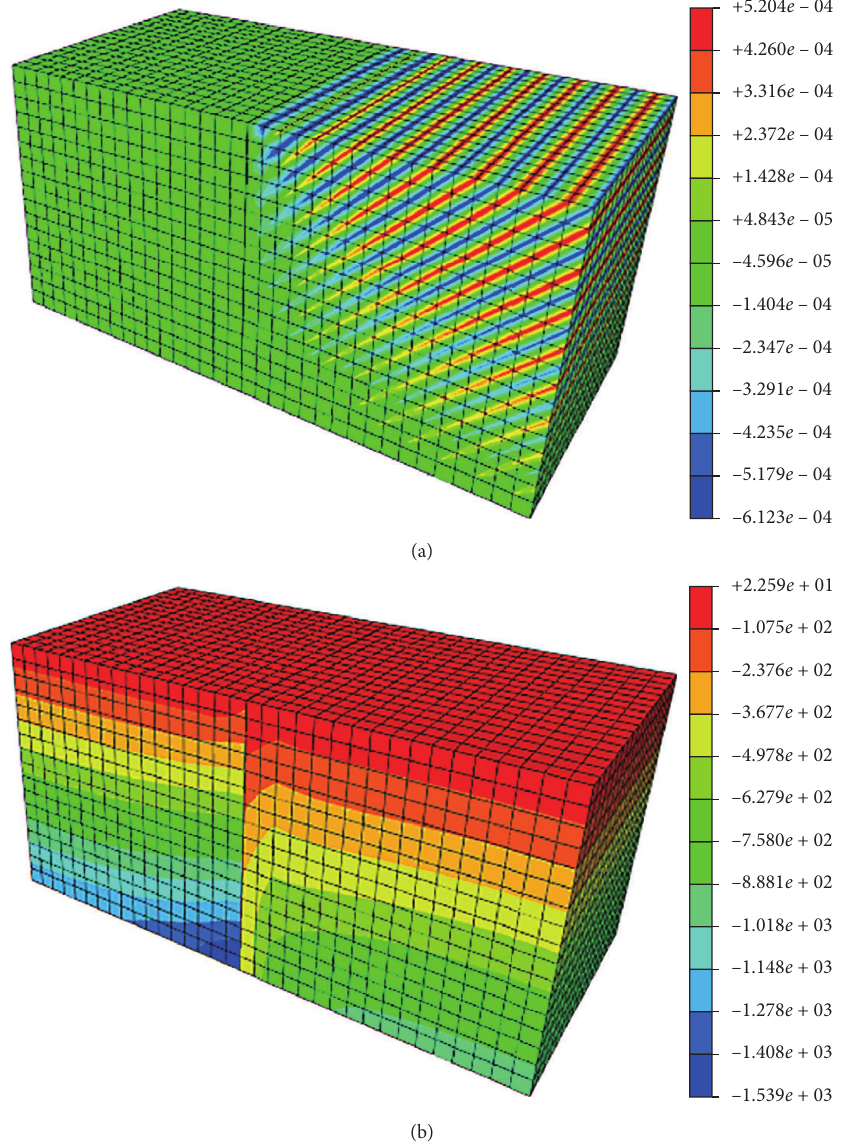
Figure 7: Simulation results of method C. (a) Vertical displacement results (unit: m) and (b) vertical stress results (unit: